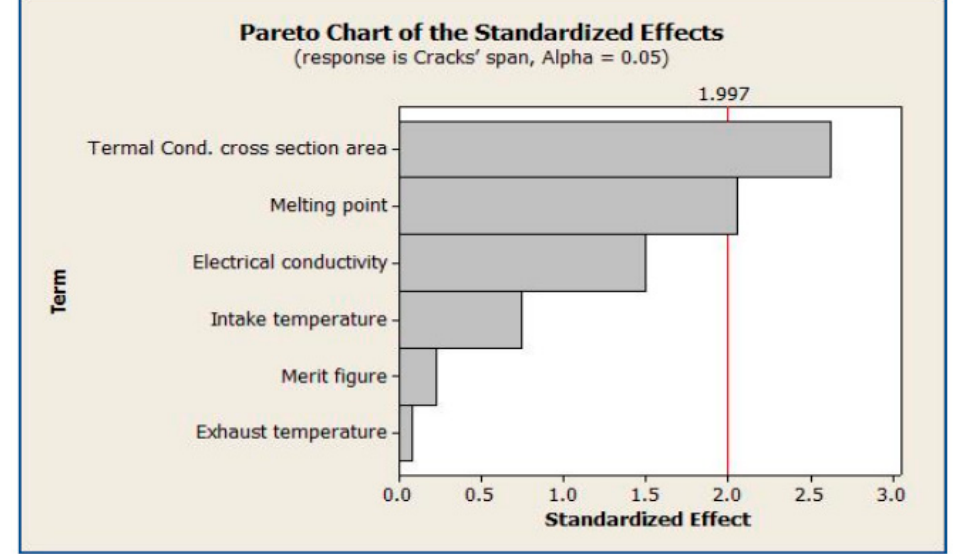
Figure 10. The significant parameters affected by power generation and cracks’ span.